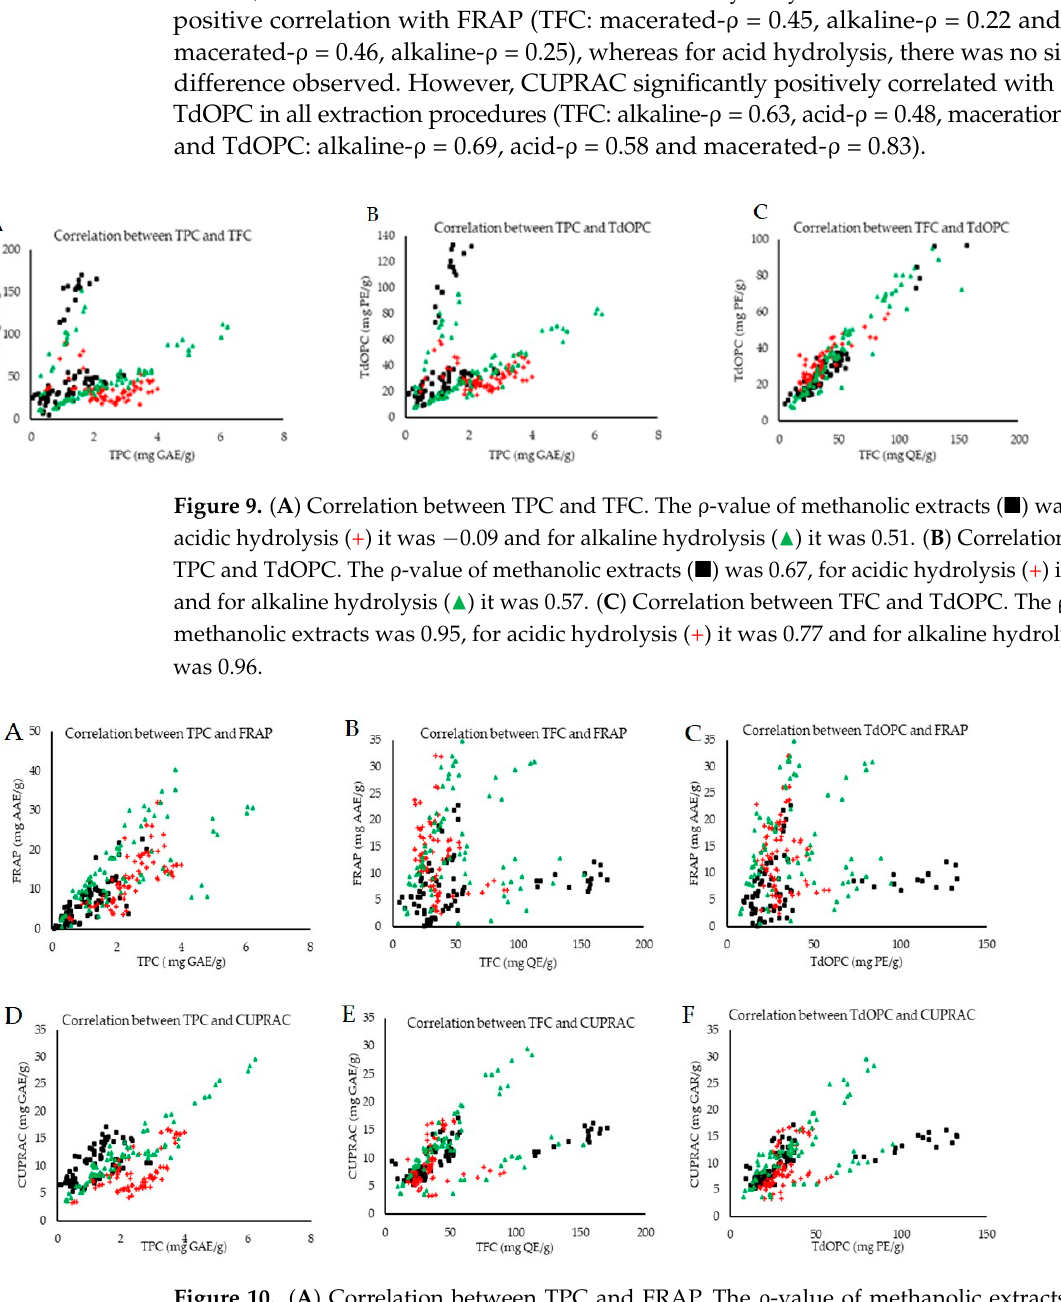
cant negative correlation with TPC in all extraction procedures (DPPH: macerated - ρ = − 0.73, alkaline - ρ = − 0.47 and acid - ρ = − 0.50 and ABTS: macerated - ρ = − 0.70, alkaline - ρ = − 0.57 and acid - ρ = − 0.47). Furthermore, it was also found that DPPH in macerated extracts had a significant negative correlation with TFC, with a ρ -value of -0.46, whereas for the hydrolysed extracts, there was no correlation observed. For ABTS, all extractions signifi- cantly negatively correlated with TFC (macerated - ρ = − 0.77, acid - ρ = − 0.21, alkaline - ρ = − 0.67). Only macerated extracts showed a significant negative correlation between DPPH and TdOPC ( ρ = − 0.43), whereas in the hydrolysed extracts, no correlation was observed. ABTS negatively correlated with TdOPC for all extraction procedures used (macerated - ρ = − 0.73, alkaline - ρ = − 0.70, acid - ρ = − 0.26). 3.3.4. Correlation between Hydrogen Peroxide and Superoxide Scavenging Activity with TPC, TFC and TdOPC Figure 11 shows the correlation of hydrogen peroxide scavenging activity with TPC, TFC and TdOPC. It was found that hydrogen peroxide significantly positively correlated with TPC and TdOPC in all extraction procedures (TPC: macerated - ρ = 0.42, acid - 0.80 and